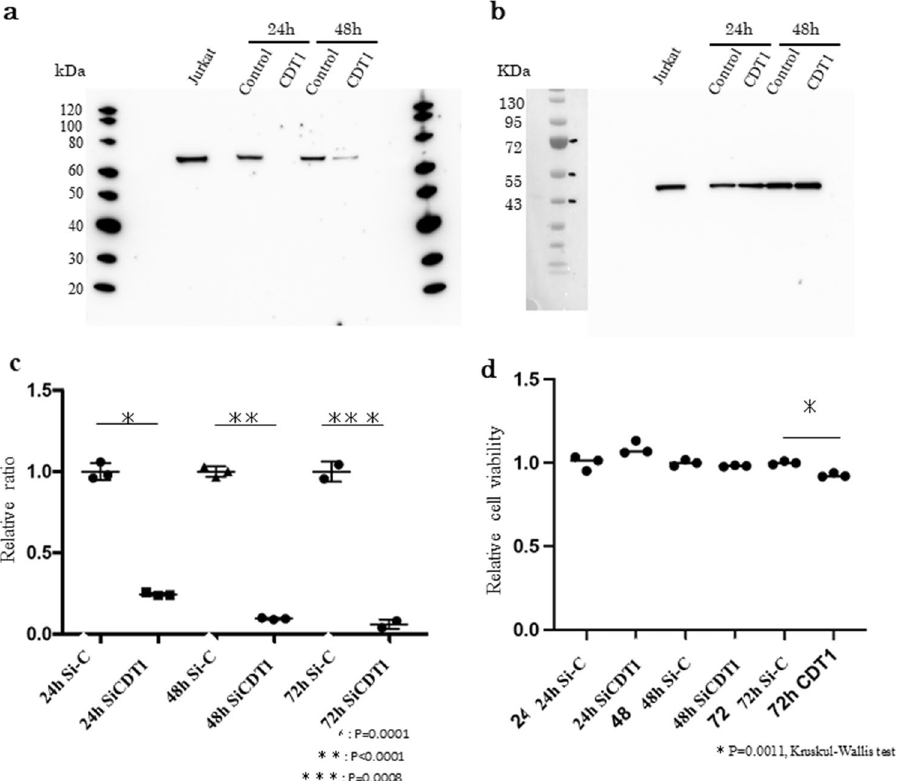
Figure 9. Representative images of Western blotting analysis of CDT1 siRNA (SiCDT1)- and control siRNA (Si–C)-transfected Huh7 cells. ( a ) Representative images of CDT1 expression in 24-h and 48-h incubated SiC- and SiCDT1-transfected Huh7 cells. Jurkat cells are a positive control. ( b ) Representative images of β-actin expression at 24 h and 48 h in the SiCDT1- and Si–C-transfected Huh7 cells. ( c ) Comparison of ΔCt value of CDT1 at 24 h, 48 h and 72 h between the Huh7 cells transfected with SiCDT1 and Si–C. (*; p = 0.0001, **; p < 0.0001, ***; p = 0.0008) Data were analyzed by the Kruskal–Wallis test. ( d ) Comparison of the results of the 3-(4,5-dimethylthiazol-2yl)-2,5-diphenyltetrazolium bromide (MTT) assay at 24 h, 48 h and 72 h using the SiCDT1 and Si–C in Huh7 cells. (*; p = 0.0011). Data were analyzed by Kruskal–Wallis